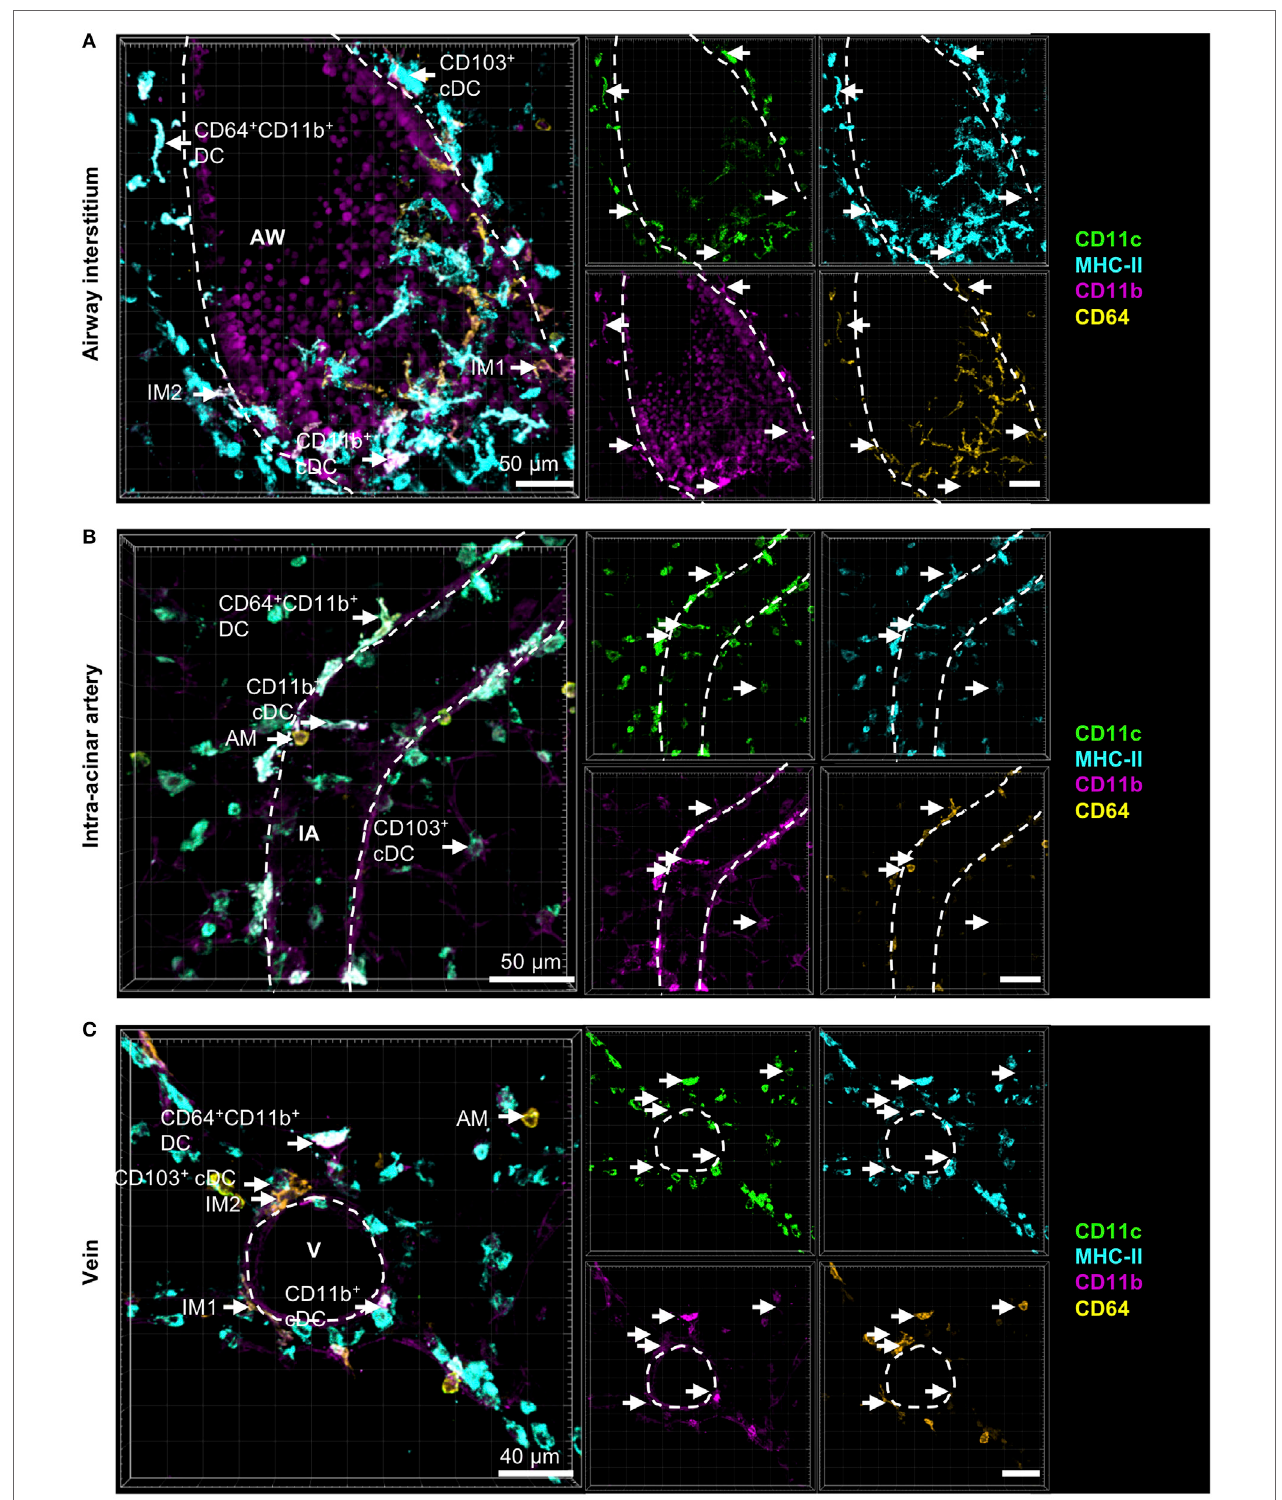
FigUre 4 | Cells with monocytic origin are located around AWs and blood vessels. Precision cut lung slices (PCLS) (300 µm) from naive C57BL/6 mice were generated and stained with anti-CD11c (green), anti-MHC-II (turquois), anti-CD11b (purple), and anti-CD64 (yellow) mABs. Stained slices were evaluated with confocal microscopy. Cells with monocytic origin were observed in the interstitium around AWs (a) , IAs (B) , Vs (c) , and in the alveolar lumen (a–c) . Dashed lines indicate structures of AWs and vessels. Abbreviations: AW, airway; V, vein; IA, intra-acinar artery. Data are representative of at least three independent